Question: What type of chart is this?
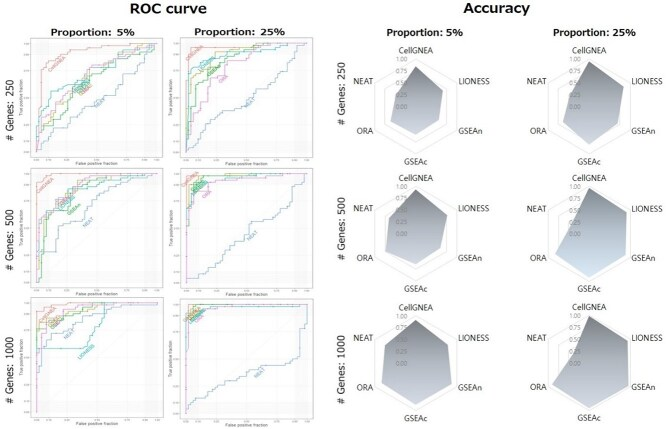
Answer: line